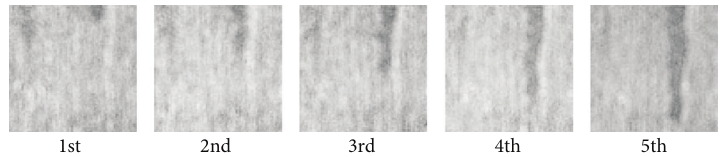
Figure 4: Reconstruction images (MR fluids under a magnetic field in different times).